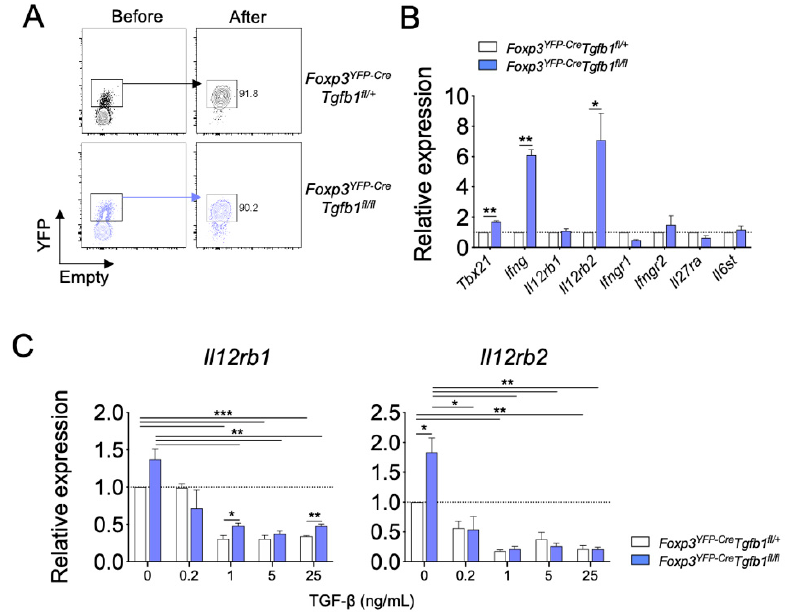
Figure 4. TGF- β 1 regulates IFN- γ production of Treg cells by downregulating IL-12 signaling. ( A ) Sorting strategy and purity of Treg cells from Foxp3 YFP-Cre Tgfb1 fl /+ and Foxp3 YFP-Cre Tgfb1 fl / fl mice. ( B ) Sorted Treg cells were stimulated anti-CD3 ε and analyzed for Th1 response-related gene expression by qRT-PCR ( n = 3). ( C ) Sorted Treg cells were cultured with TGF- β 1 (0.2, 1, 5, and 25 ng / mL) in the presence of anti-CD3 ε and IL-12, and the relative Il12rb1 and Il12rb2 expression was analyzed by qRT-PCR. Data are representative of three independent experiments, and values are expressed as the mean + SEM ( B , C ). * p ≤ 0.05, ** p ≤ 0.01, and *** p ≤ 0.0001 compared to control Treg cells based on Student’s t -test.